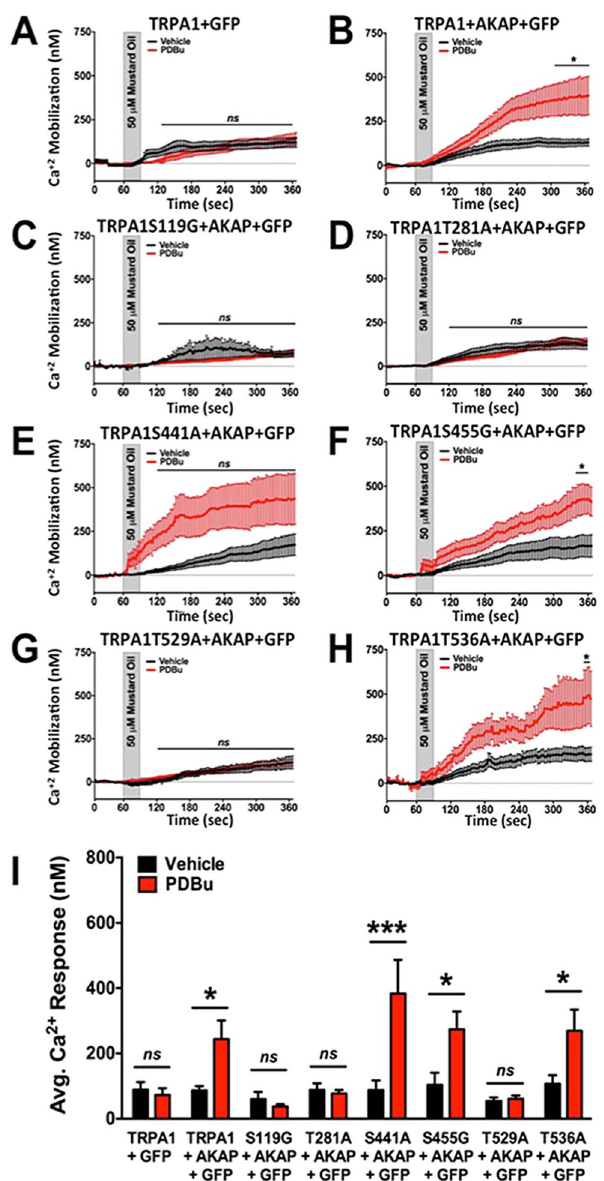
Figure 6. Site-Directed Mutagenesis of Potential PKC phosphorylation sites on TRPA1. Cumulative traces from Chinese hamster ovary (CHO) cells transiently transfected with various cDNAs in the following combinations: ( A ) TRPA1 and empty green fluorescence protein vector (GFP), ( B ) TRPA1, AKAP and GFP, ( C ) TRPA1 S119G, AKAP and GFP, ( D ) TRPA1 T281A, AKAP, and GFP, ( E ) TRPA1 S441A, AKAP, and GFP, ( F ) TRPA1 S455G, AKAP, and GFP, ( G ) TRPA1 T529A, AKAP, and GFP, ( H ) TRPA1 T536A, AKAP, and GFP. Real-time Ca 2 + accumulation measurements were recorded from GFP-positive cells following vehicle (black) or PDBu (1 μ M, red) pre-treatment (5 min) to a mustard oil (MO, 50 μ M, 30 sec) challenge. *** p < 0.005; * p < 0.05; ns = no significance; one-way ANOVA. ( I ) Quantified results from cumulative recordings (n = 24–64/cDNA transfection paradigm), ns = no significance; *** p < 0.005; ** p < 0.01; trace significance determined by two-way ANOVA with Bonferroni posthoc analysis and quantified data significance determined by unpaired student’s t